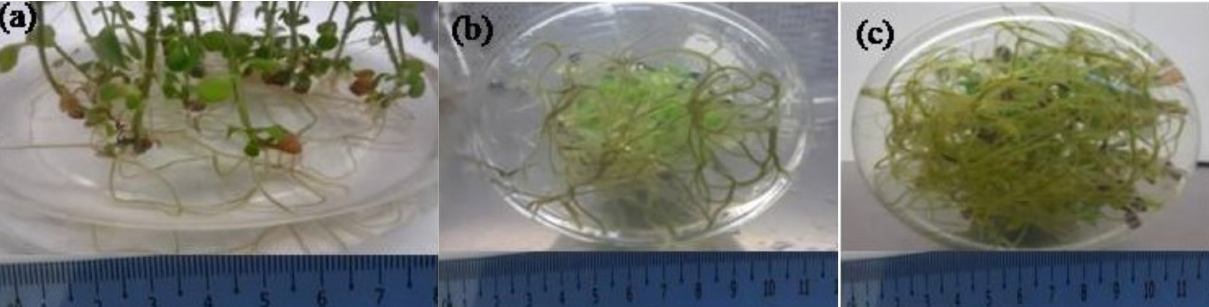
Figure 6. Regenerated roots from stevia shoot on different strengths of MS media at 30 DACI: ( a ) initiated roots on 0.25 MS media; ( b ) initiated roots on 0.50 MS media; and ( c ) initiated roots on 1.00 MS media.